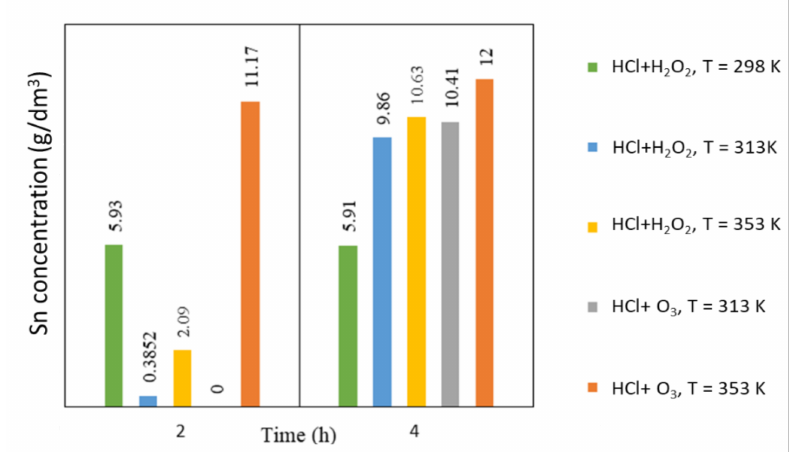
Figure 4. Tin concentration obtained after leaching in HCl with the addition of H 2 O 2 or O 3 during 2 h and 4 h.